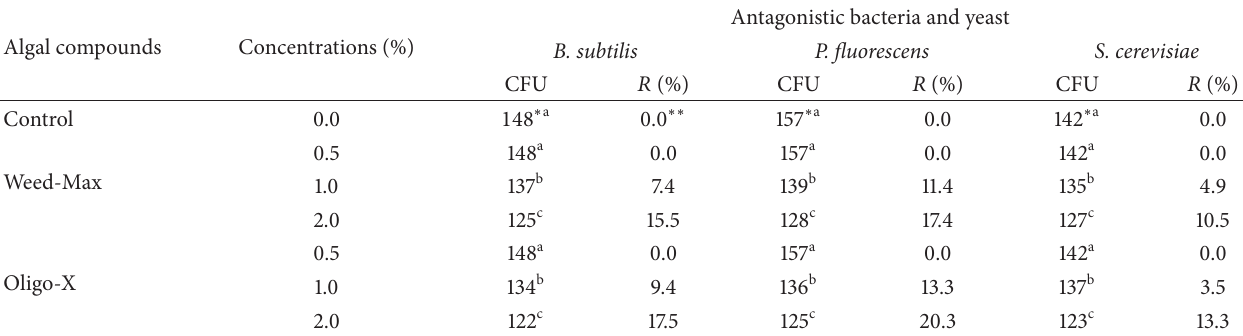
Table 2: Effect of algal compounds on the viability of some antagonistic bacteria and yeast in vitro .